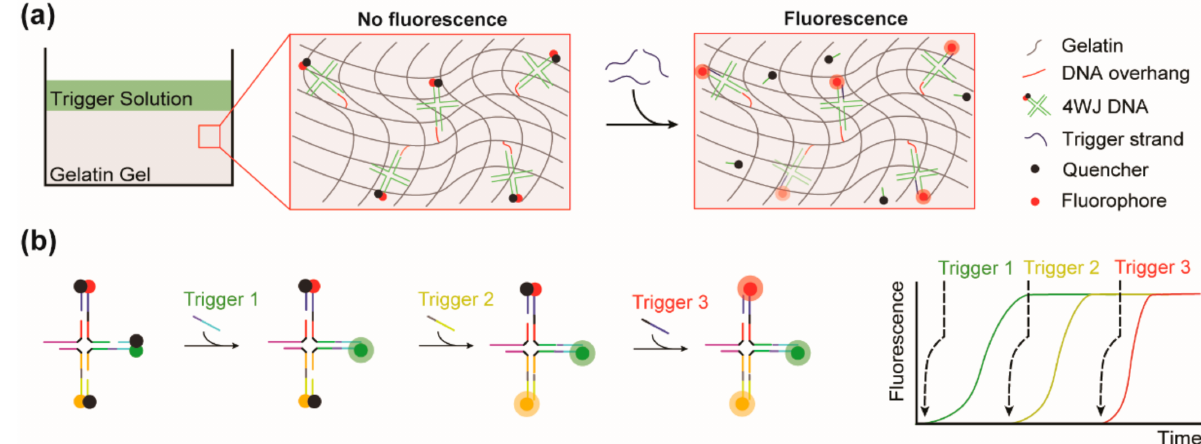
Figure 1. Graphical representation of the DNA-Gel hydrogel system and the SDR-based sequential release mechanism. ( a ) Schematic showing the DNA motifs inserted in the gelatin hydrogel via click chemistry and illustrating the release mechanism within the gelatin hydrogel using strand displacement reaction. ( b ) Schematic of the sequential release mechanism developed on the DNA motifs showing specific release of the fluorescent cargo based on the sequential use of trigger strands. The increase in fluorescence indicates the separation of the quencher and the fluorophore. The quencher and fluorophore are used to quantify the cargo release in our